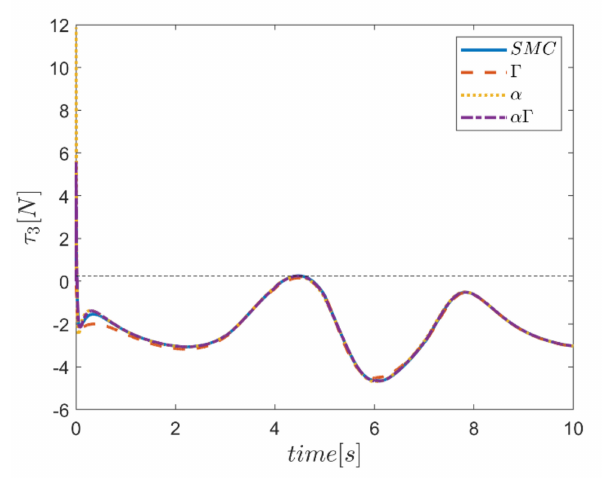
Figure 30. Comparison of the input force in the third actuator.